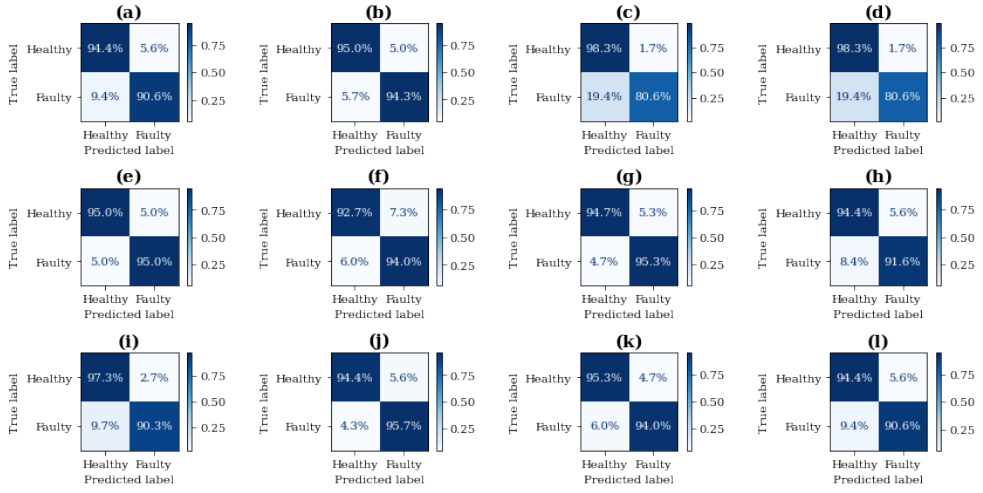
Figure 13. Confusion matrix by ( a ) LR, ( b ) KNN, ( c ) SVM-Lin, ( d ) SVM–RBF ( C = 10), ( e ) GBC (number of estimators = 1000), ( f ) DT, ( g ) RF, ( h ) MLP, ( i ) NBC, ( j ) ABC, ( k ) QDA, and ( l )